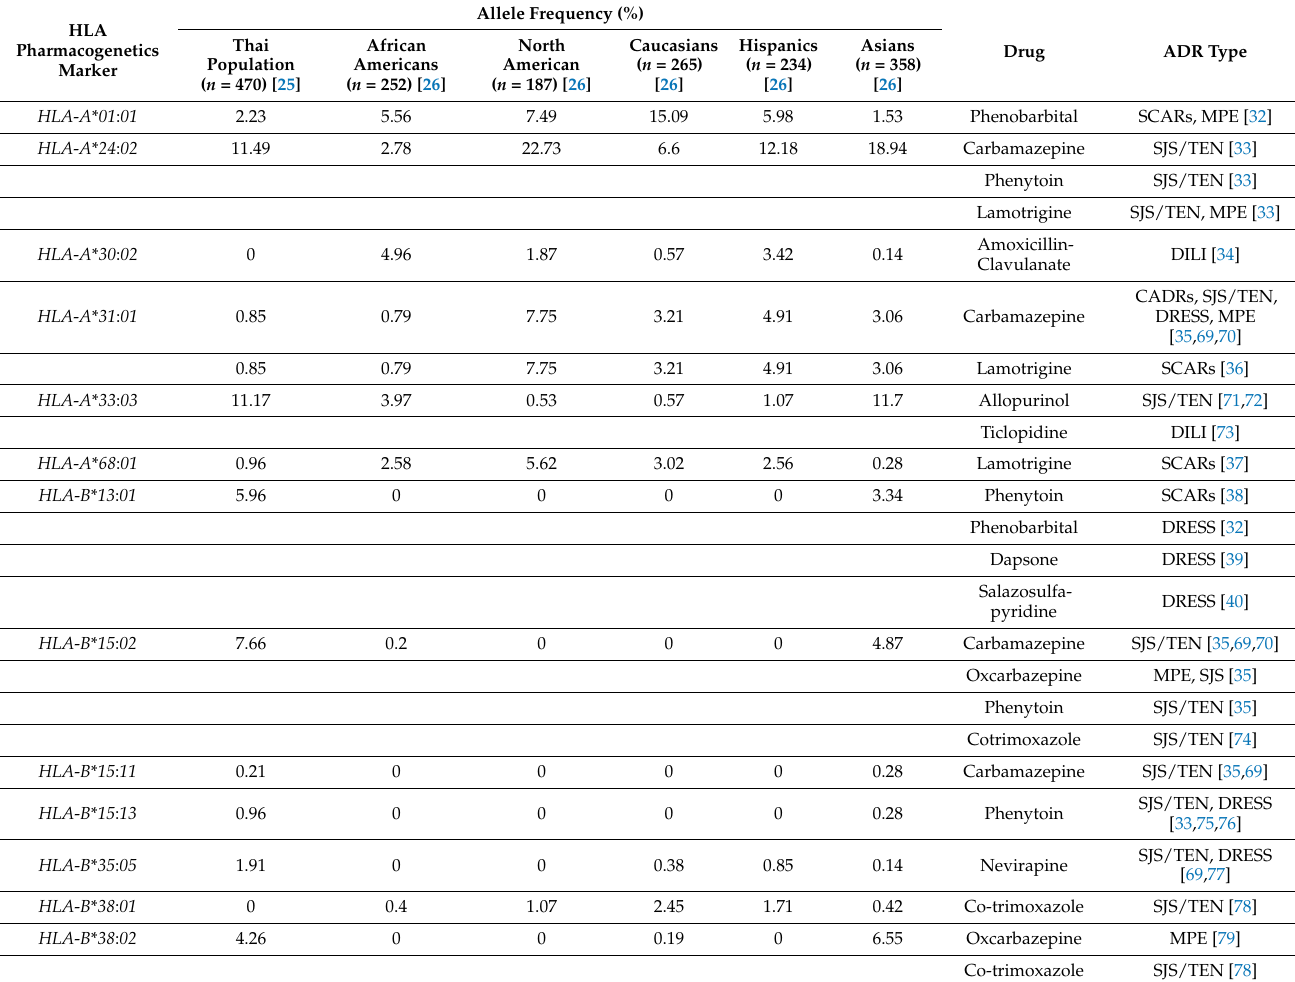
Allele Frequency